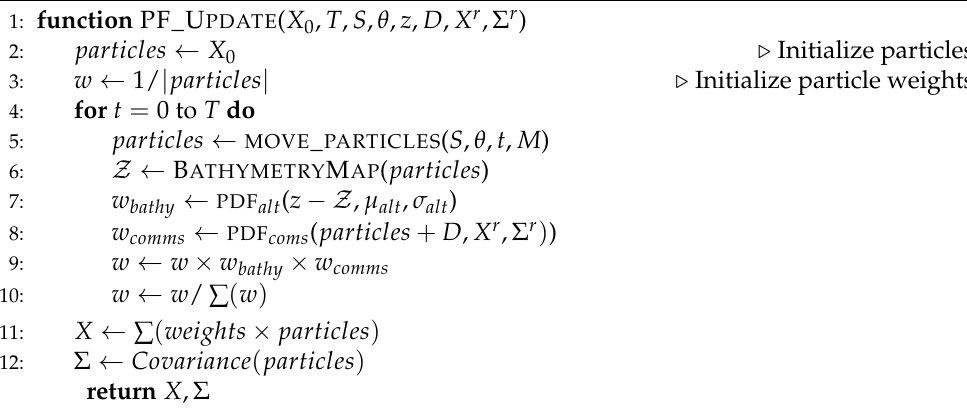
Algorithm 2 Particle Filter Update with a Received Communication